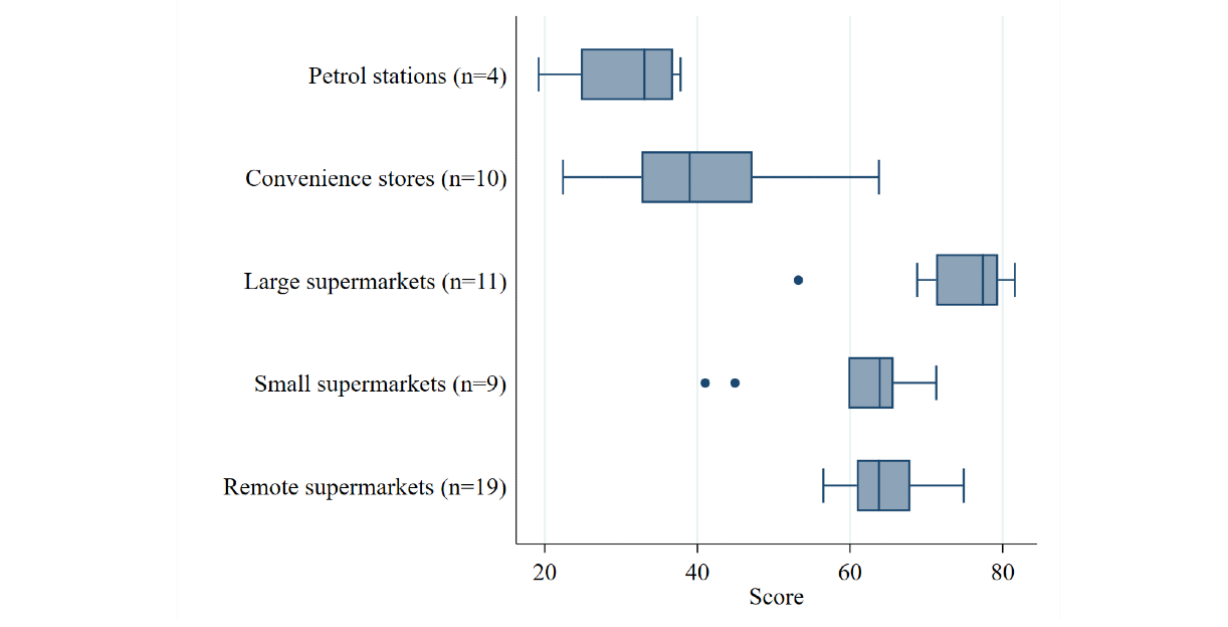
Figure 2. Distribution of overall scores by store